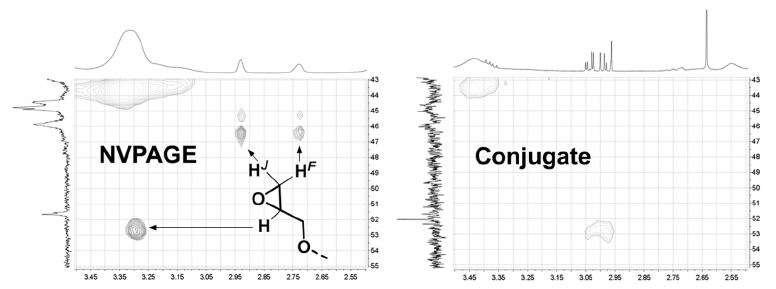
Figure 4. Fragments of the HSQC spectra of the original NVPAGE polymer and the vectorized conjugate based on it. We also analyzed the signals of the carbohydrate residues in the vectored conjugate.